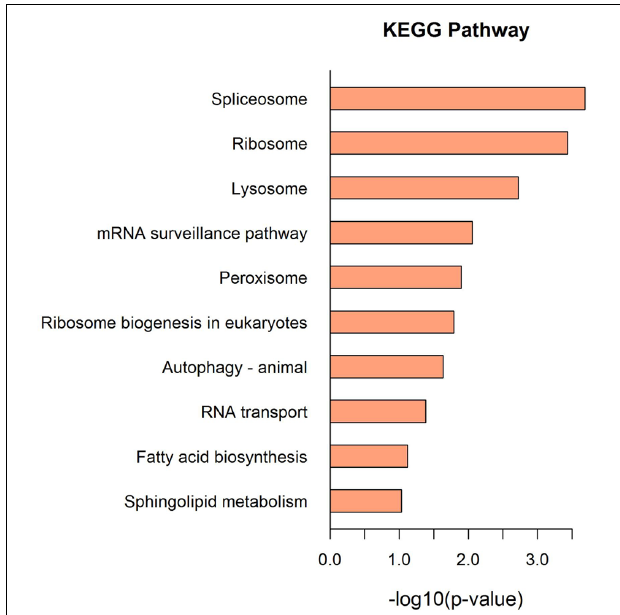
FIGURE 4 | The KEGG pathway enrichment analysis of the DEPs. Top 10 enrichment in KEGG pathway maps of the DEPs. P -value was calculated using Fisher’s exact